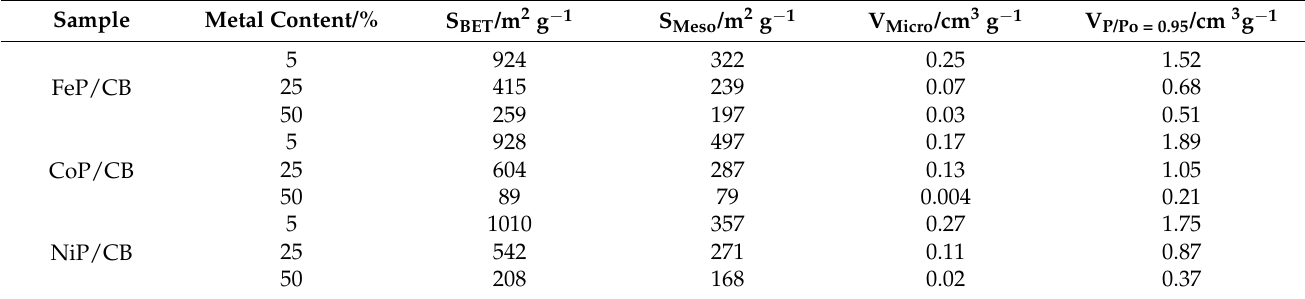
Table 2. Textural properties of the phosphorized catalysts on